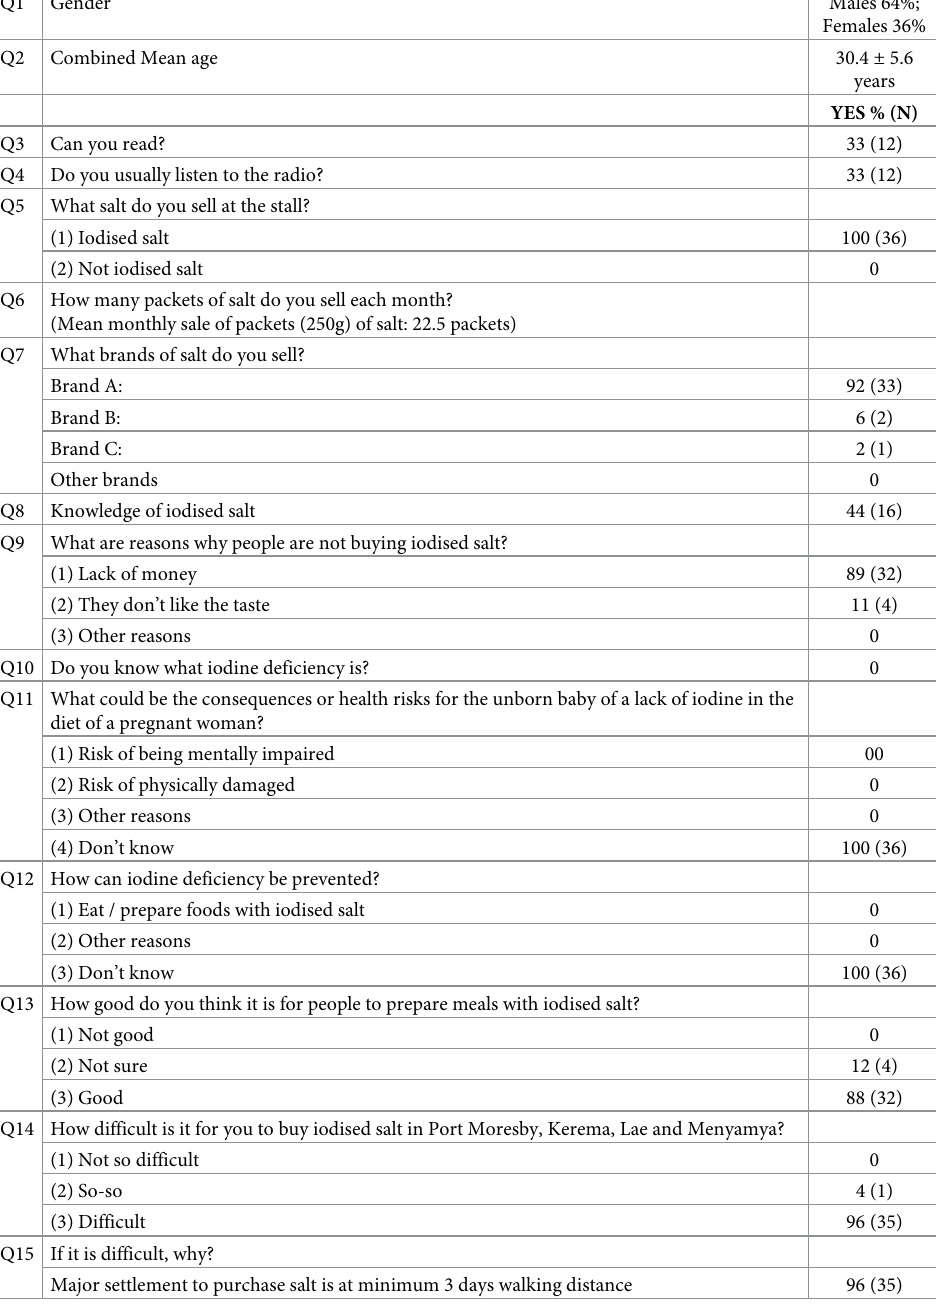
Table 3. Among the stallholders 67% reported that they cannot read and 67% do not listen to Table 3. Knowledge, attitude and practices of stallholders selling salt (n =